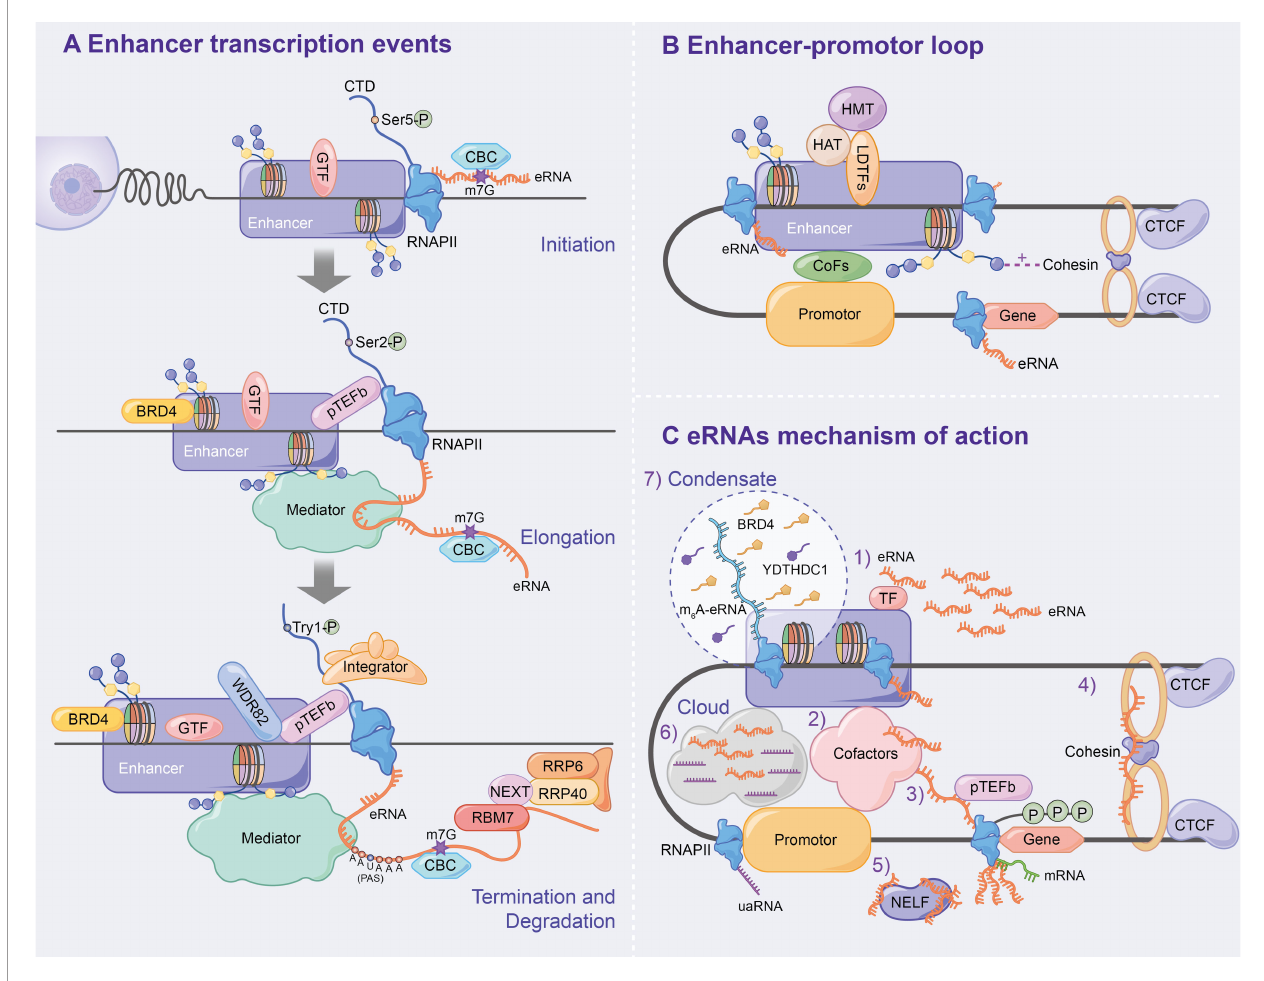
FIGURE 3 | Mechanism of enhancer transcription and eRNAs to regulate target genes. (A) Following enhancer activation, GTFs and serine 5-phosphorylated form of RNAPII (Ser5p) are recruited, which leads CBC to binding to eRNA via m7G, ultimately initiating enhancer transcription. During the enhancer elongation, Ser2p is hypoenriched. pTEFb, BRD4 and the eRNAs being transcribed all affect transcription elongation. Subsequently, the nascent eRNAs interacts with RNAPII CTD to terminate transcription. In addition, the integrator, WDR82 and Tyr1p assist in correct enhancer transcription termination. Finally, the NEXT complex mediates the degradation of eRNAs. (B) Chromatin loops are generated under the in fl uence of LDTFs, histone methylation or acetylation, cohesin-CTCF complex and interphase chromosome topologically associated domain, and ultimately activate target gene transcription. (C) Speci fi c mechanisms have been demonstrated for eRNAs to affect enhancer activity, E-P loop formation, and transcription of downstream target